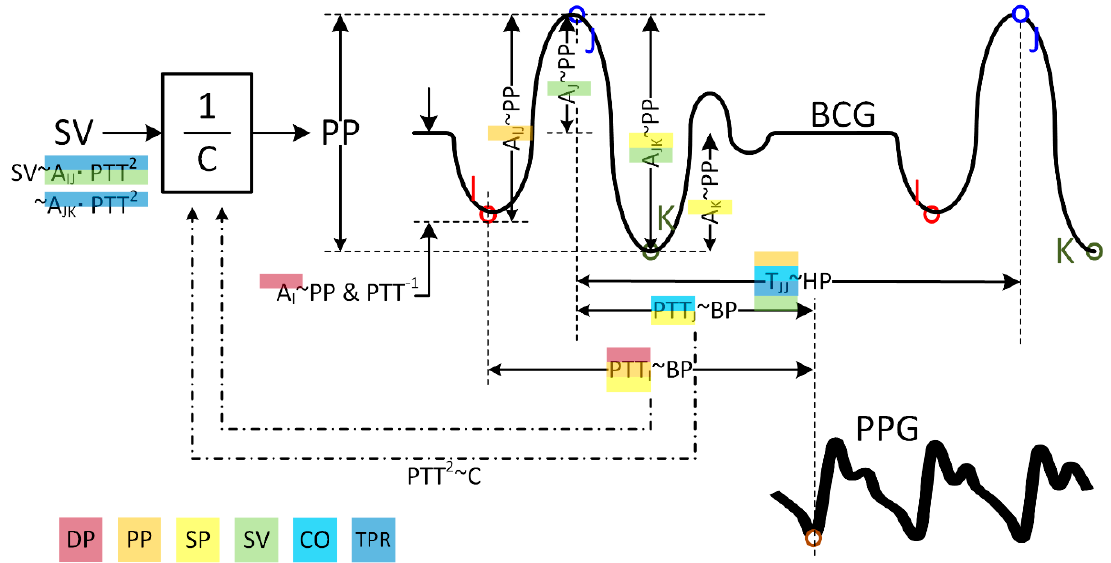
Figure 6. Relationship between the characteristic features in the weighing scale and armband BCG and the CV parameters. BP: blood pressure. DP: diastolic BP. PP: pulse BP. SP: systolic BP. SV: stroke volume. CO: cardiac output. TPR: total peripheral resistance. HP: heart period. C: arterial compliance. “X~Y” means that X and Y are proportional.